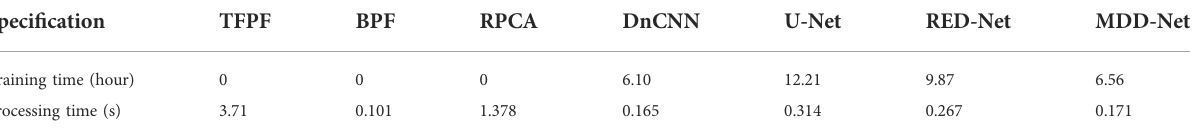
TABLE 5 The computational cost for different attenuation